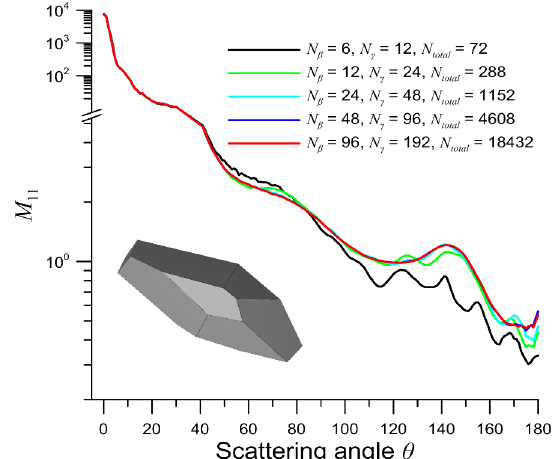
Figure 1. First element of the Mueller matrix for a randomly oriented dust particle calculated with the physical-optics approximation for different number of particle